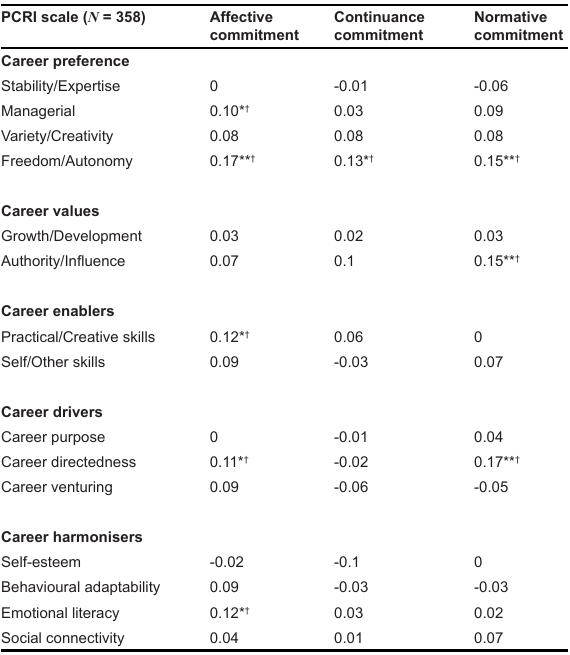
TABLE 2 Pearson’s product-moment correlations: PCRI and